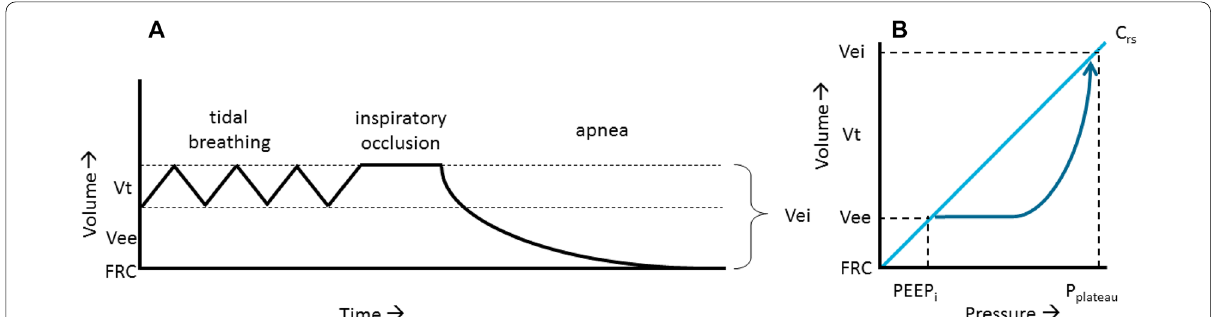
Fig. 1 A Schematic representation of the volume at end-inspiration (Vei), which is the volume at end-expiration (Vee) above the functional residual capacity plus tidal volume, measured after prolonged apnea. B Schematic representation explaining the rationale of the formula to estimate Vei, with pressure on the x-axis and volume on the y-axis. In a patient with dynamic pulmonary hyperinflation inspiration starts from the total amount of positive end-expiratory pressure (PEEP total ). PEEP total can be obtained by performing an end-expiratory occlusion maneuver (i.e., zero flow conditions, after an occlusion of a few seconds PEEP total represents the alveolar pressure). If applied PEEP by the ventilator is 0 cmH 2 O, which is the case in the current study, PEEP total represents intrinsic PEEP (PEEP i ). The patient inhales a certain volume (Vt) reaching an inspiratory pressure depending on the mechanical characteristics of the lung. By performing an end-inspiratory occlusion maneuver the plateau pressure ( P plateau ) can be obtained, which corresponds to Vei. Compliance ( C rs ) is defined as the slope of the volume pressure relationship, e.g., the ratio of a change − in volume and pressure, for the respiratory system this means: Vt/( P plateau PEEP i ) (1). From the figure it is clear that C rs can also be calculated as − Vei/ P plateau (2). Therefore, Vei is Vee plus Vt, but also C rs times P plateau (3). Combining [1], (2) and (3) gives Vei formula (Vt)/ P plateau –PEEP i ) * P plateau (4) = which can be rewritten as Vei formula (Vt * P plateau )/( P plateau –PEEP i ) (5). This rationale holds true when C rs remains =